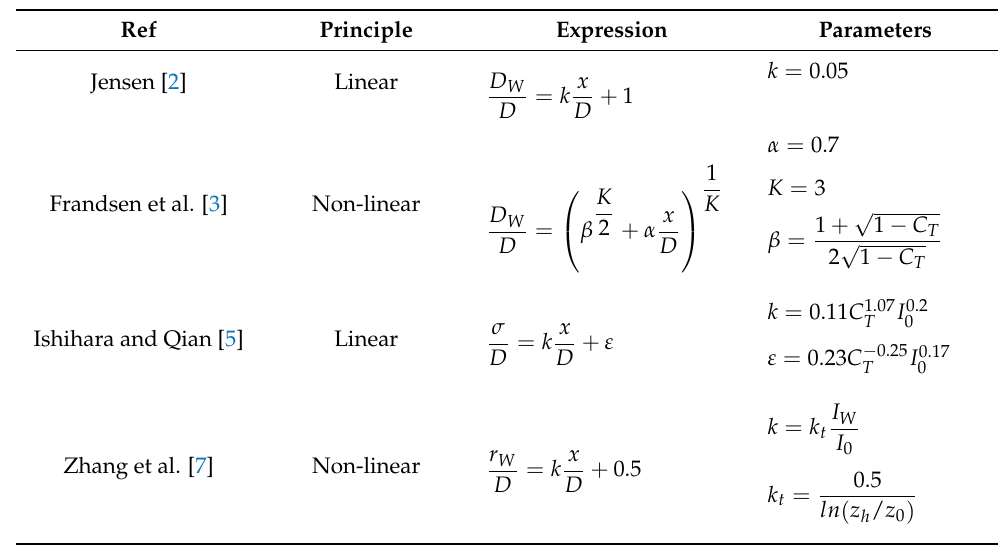
Table 2. Empirical models for wake boundary